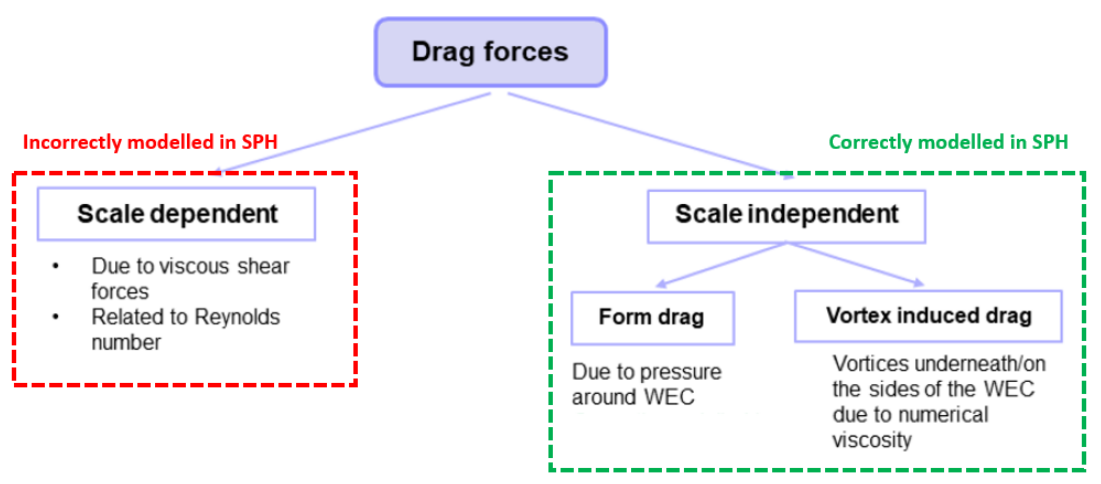
Figure 2. Schematic overview of different drag forces acting on the Wave Energy Converter